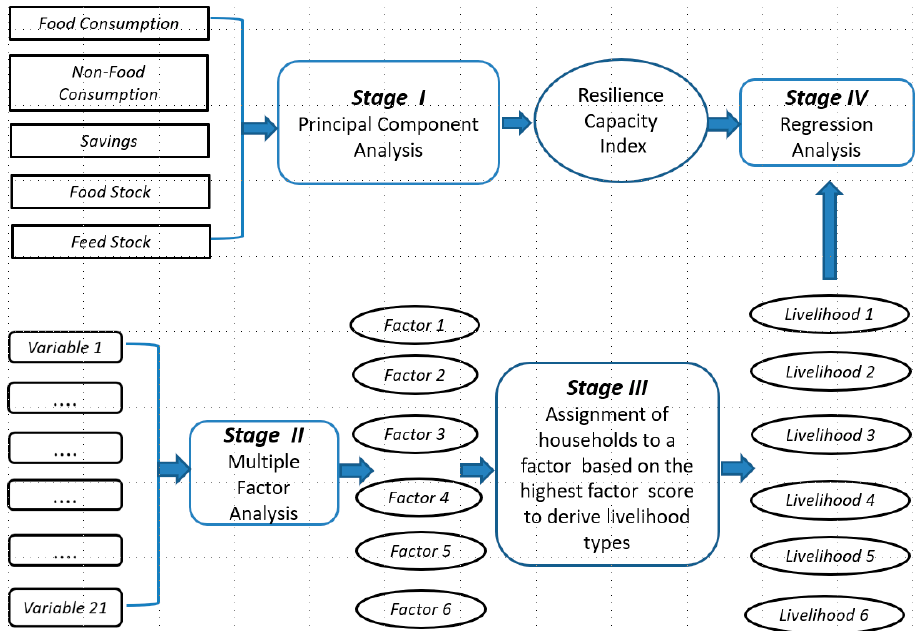
Figure 2. Overview of analytical framework.